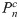
Virality and opinion polarization.In these graphs, we look V(θc, Pn, Po) (i.e. at the critical threshold level) for each level of Po (opinion polarization) (note: since θc varies with Po, the lines in the graphs cannot be compared with regard to the absolute level of virality.) The different lines denote different level of opinion polarization (Po). The upper graph shows the case (when the echo chamber is polarized), and the lower the control (when opinion polarization is assigned to random nodes in the network.) As can be seen, in the case, Po (the level of opinion polarization) affects Pnc, i.e. at what level of network polarization that virality peaks. In the control case, there is no such effect.